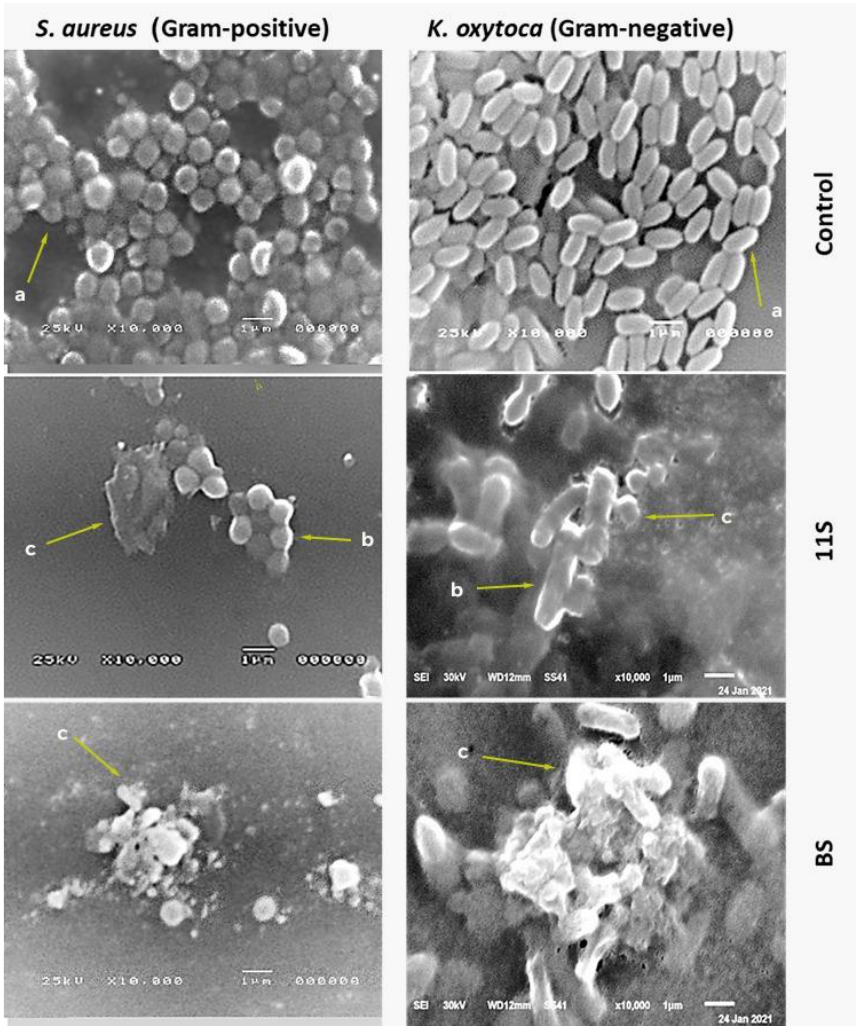
Figure 7. Scanning electron microscopic (SEM) images (10,000 X) of S. aureus (Gram-positive) and K. oxytoca (Gram- negative) as affected by 0.5 μg/mL 11S globulin and 0.5 μg/mL BS. The small letters oxytoca (Gram-negative) as affected by 0.5 µ g/mL 11S globulin and 0.5 µ g/mL BS. The small of a, b, and c refer to normal, intermediary, and completely deformed bacterial cells, respectively. 2.5. Comparison of the MIC of Tested Lupine (11S and BS) with Specific Antibiotics for Each